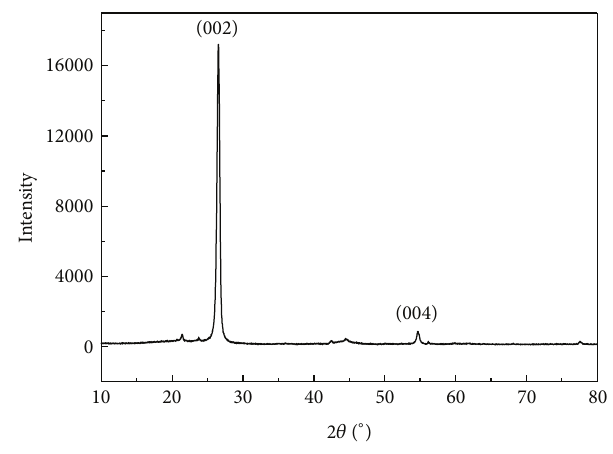
Figure 2: XRD pattern of the MEG